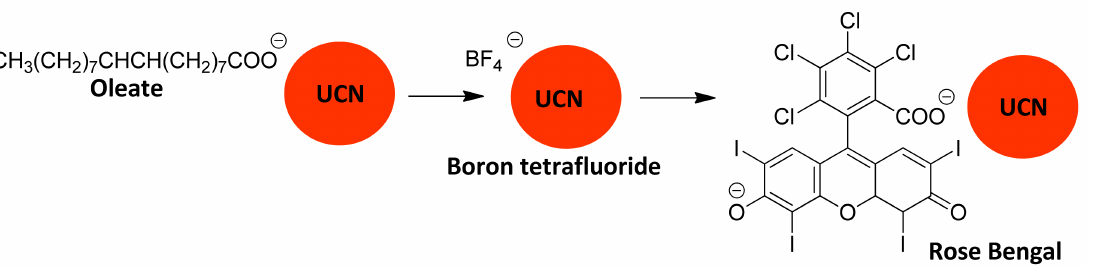
Figure 6. Nitrosyl tetrafluoroborate mediated ligand exchange to replace oleate with fluorescent rose